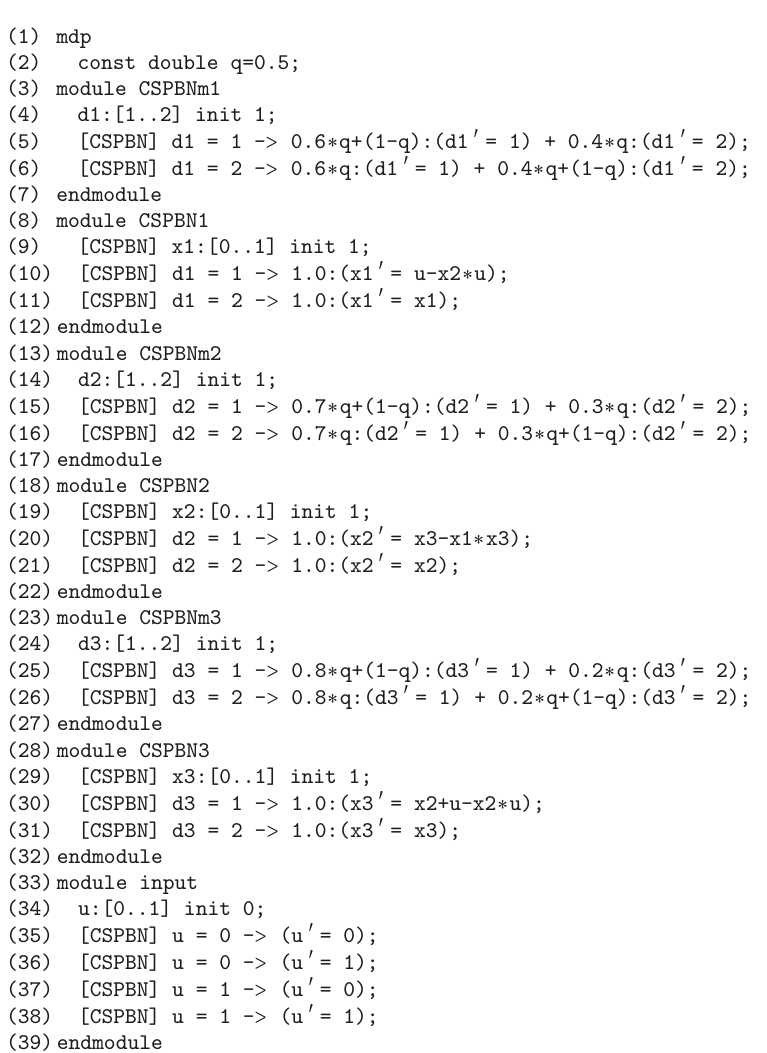
Figure 3: PRISM code expressing the